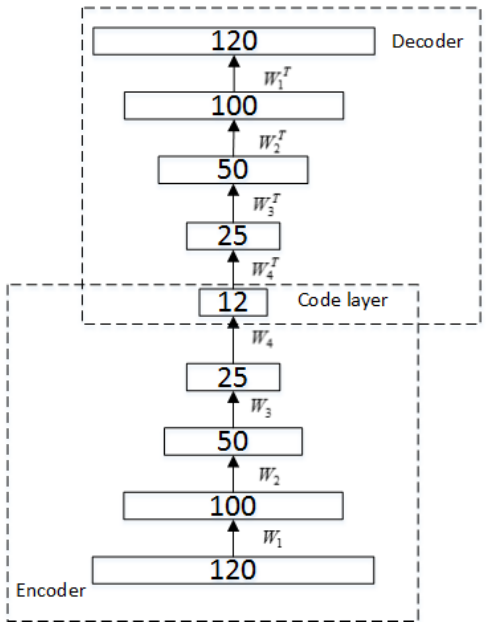
Figure 3. Stacked RBM-AE.